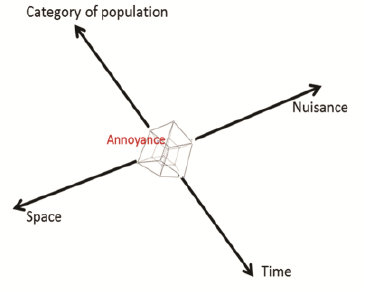
Figure 1. Multidimensional representation of